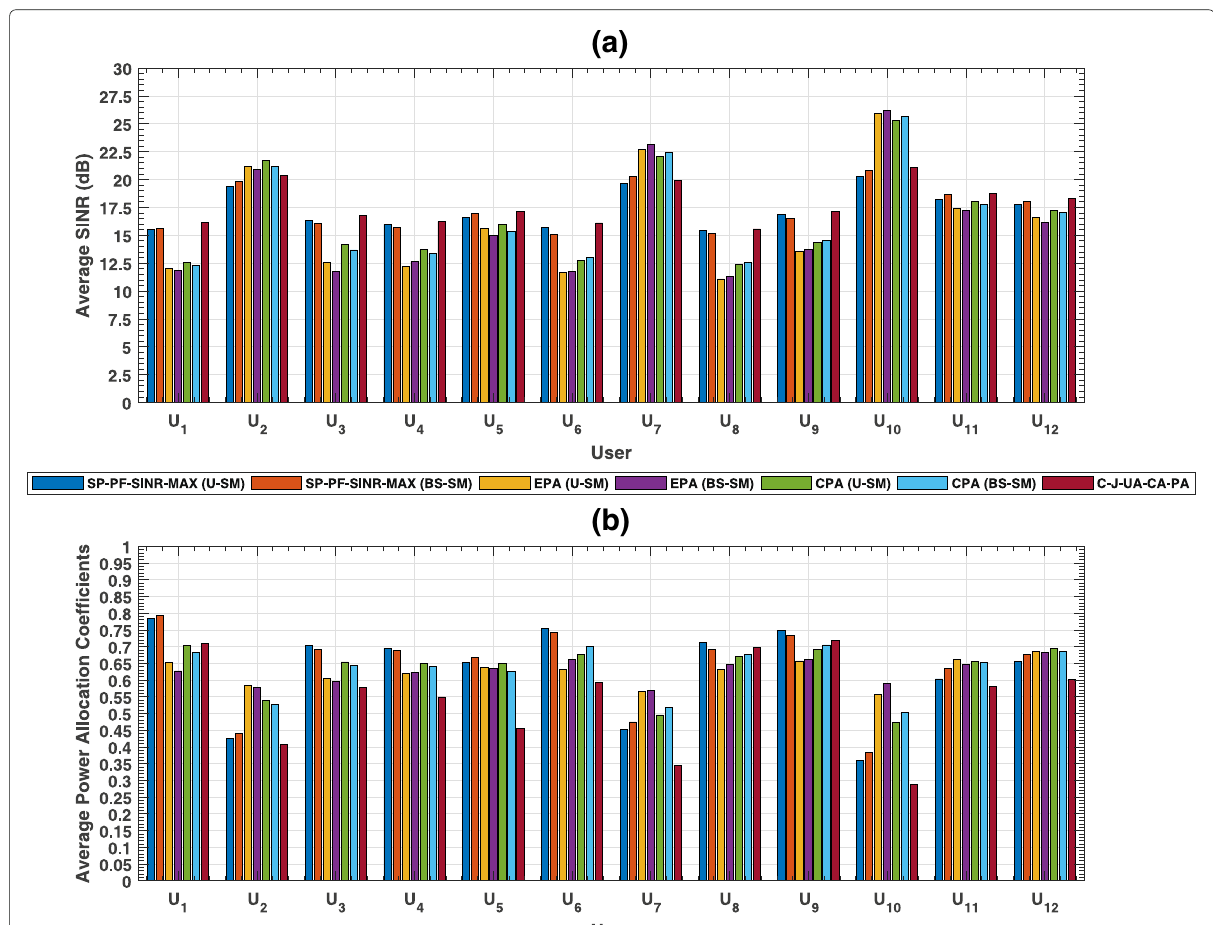
Fig. 4 a Average SINR (dB) and b average power allocation coefficients—Scenario